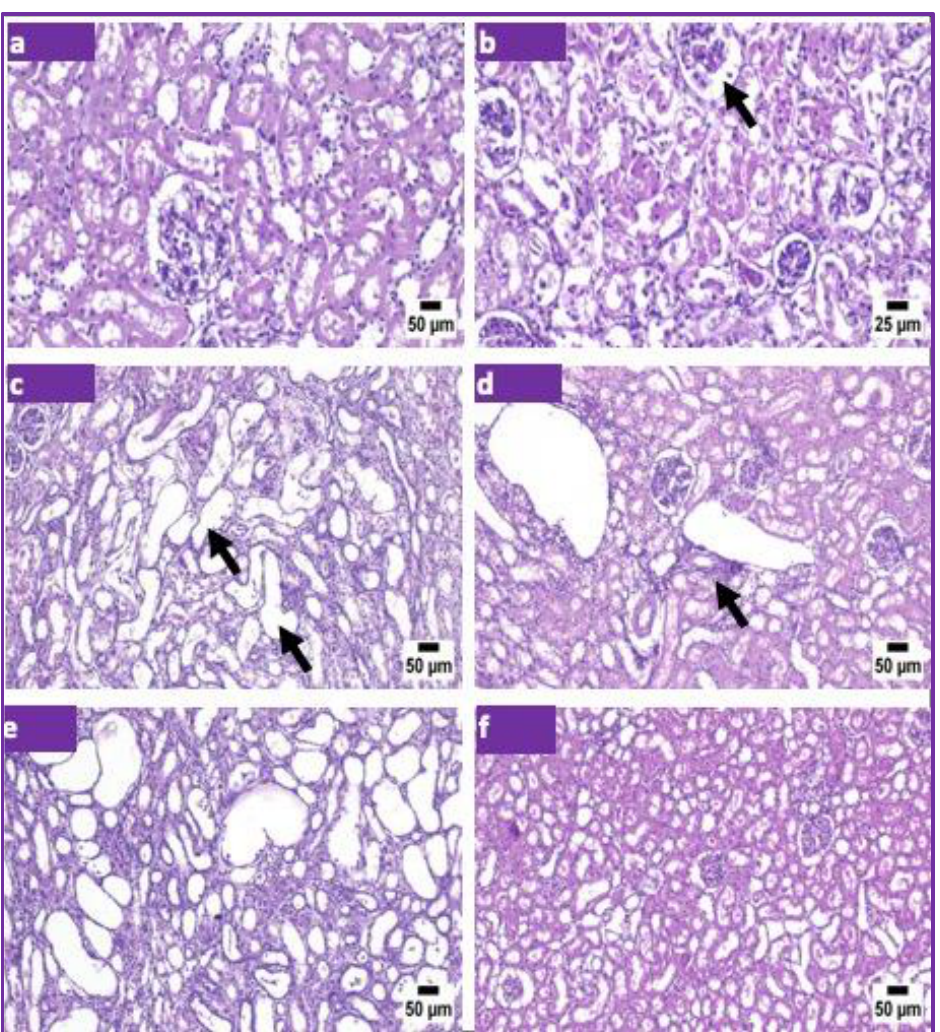
Figure 4. Histopathological analysis of kidneys of treated and untreated animals. ( a ) Photomicro- graph of the kidney of the control group showing normal renal cortex. ( b ) Positive control group (received cisplatin) showing necrotic renal tubules. ( c ) Positive control group showing interstitial nephritis with cystically dilated tubules in the renal cortex (arrows). ( d ) The mesenchymal stem cell group showing interstitial nephritis. ( e ) The Asian pigeonwing group showing severe cystically di- lated renal tubules associated with interstitial nephritis. ( f ) The Asian pigeonwing with mesenchy- mal stem cell group showing normal renal cortex.